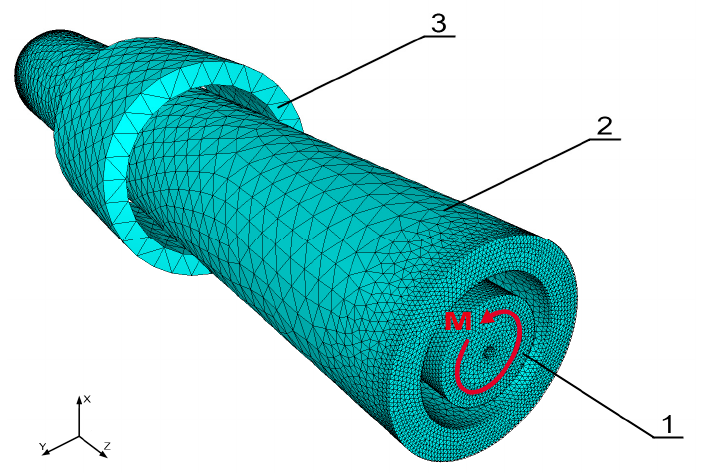
Figure 2. The tetrahedral mesh of the modelled system; 1—shaft, 2—magnetizing coil, 3—sensing